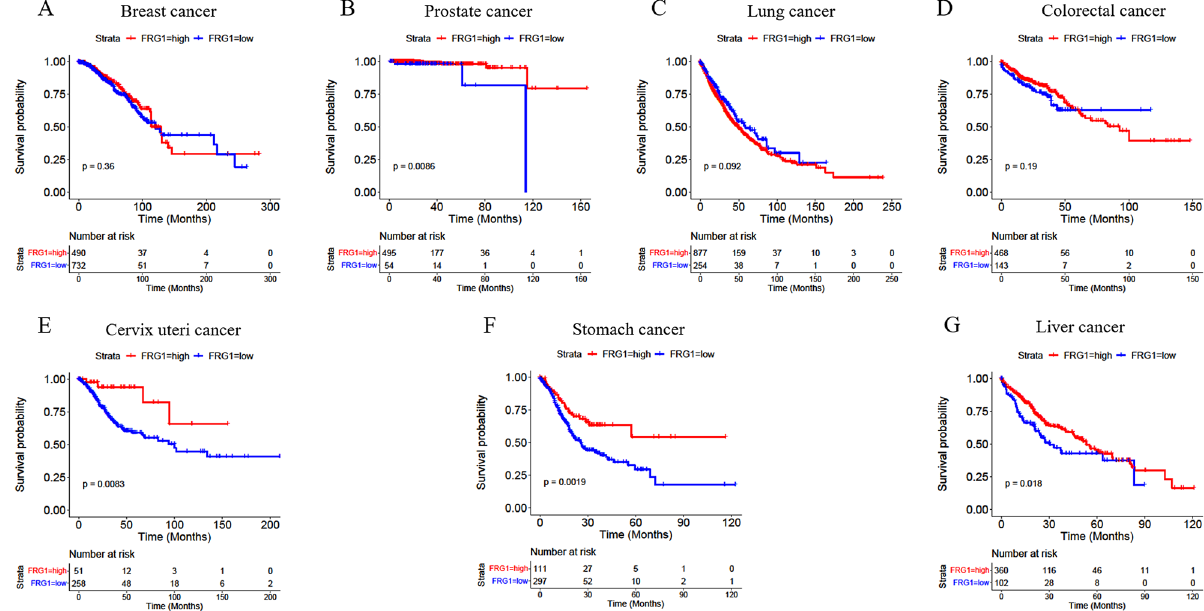
Figure 2. Kaplan–Meier plots showing overall survival with respect to FRG1 mRNA expression levels in different cancer types. Survival curves are shown for ( A ) Breast cancer (logrank P = 0.36), ( B ) Prostate cancer (logrank P = 0.0086), ( C ) Lung cancer (logrank P = 0.092) ( D ) Colorectal cancer (logrank P = 0.19) ( E ) Cervix uteri cancer (logrank P = 0.0083), ( F ) Stomach cancer (logrank P = 0.0019) and ( G ) Liver cancer (logrank P = 0.018). The X-axis represents the number of patients at risk at specific time (in months) and Y-axis shows the probability of survival. Red lines indicate FRG1-high expression group and blue lines indicate FRG1-low expression group divided based on logrank P